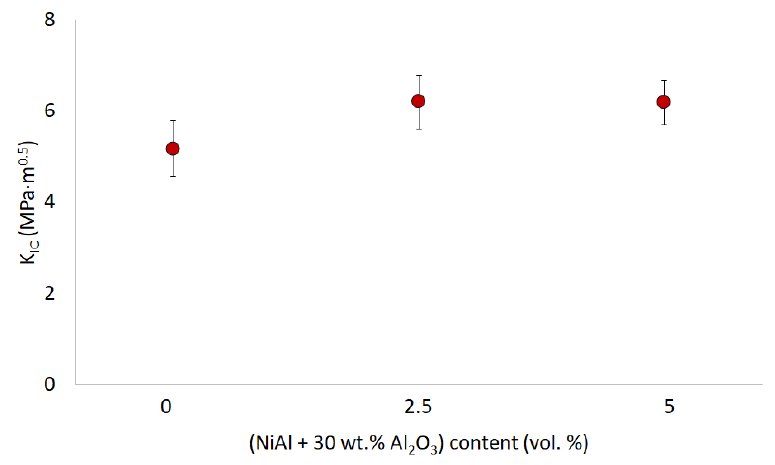
Figure 16. Fracture toughness of the samples obtained.